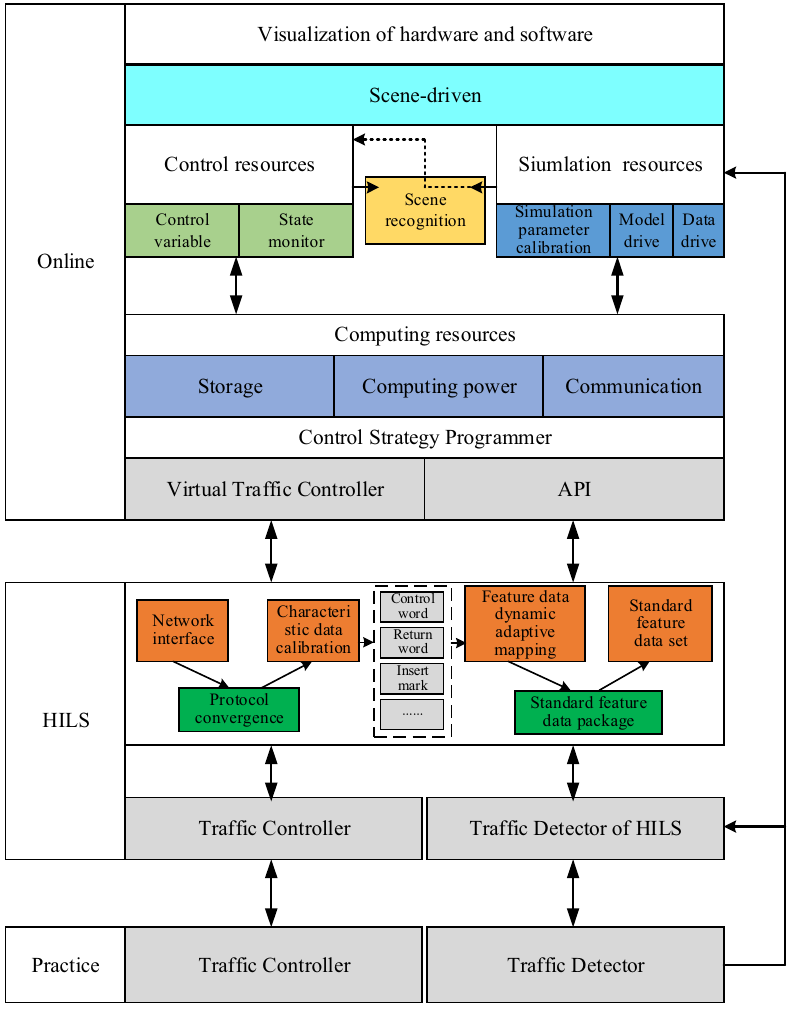
Figure 1. Traffic control simulation integrated platform